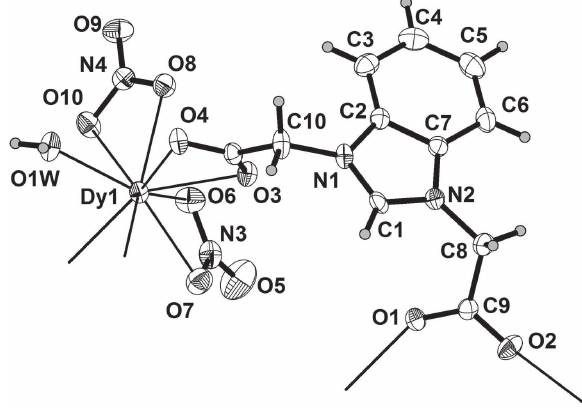
Table 1: Data collection and